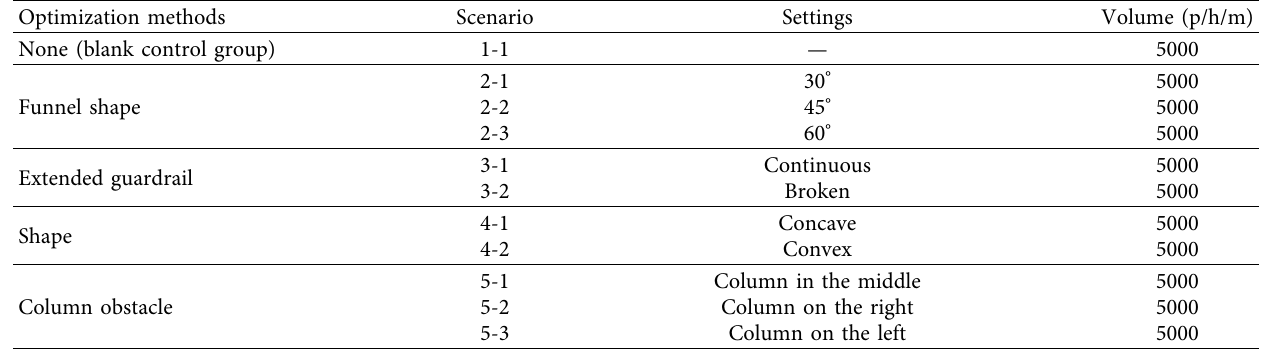
Table 1: Experiments scenario